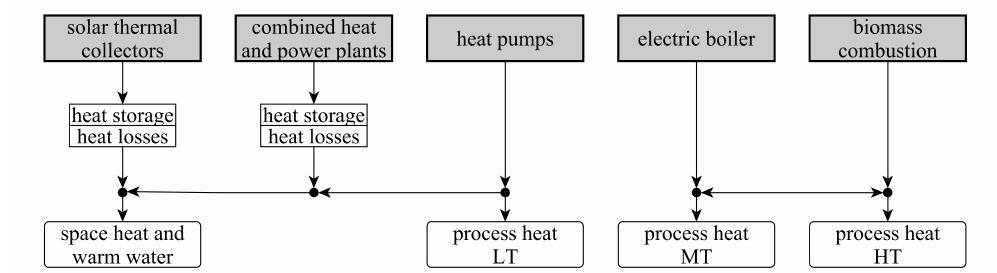
Figure 5. Systems used for space heating, hot water, and process